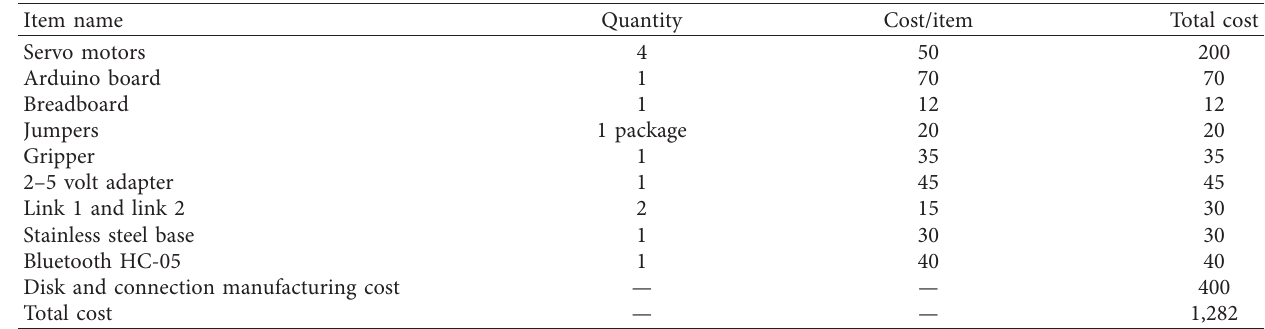
— — 94 Table 4: System development